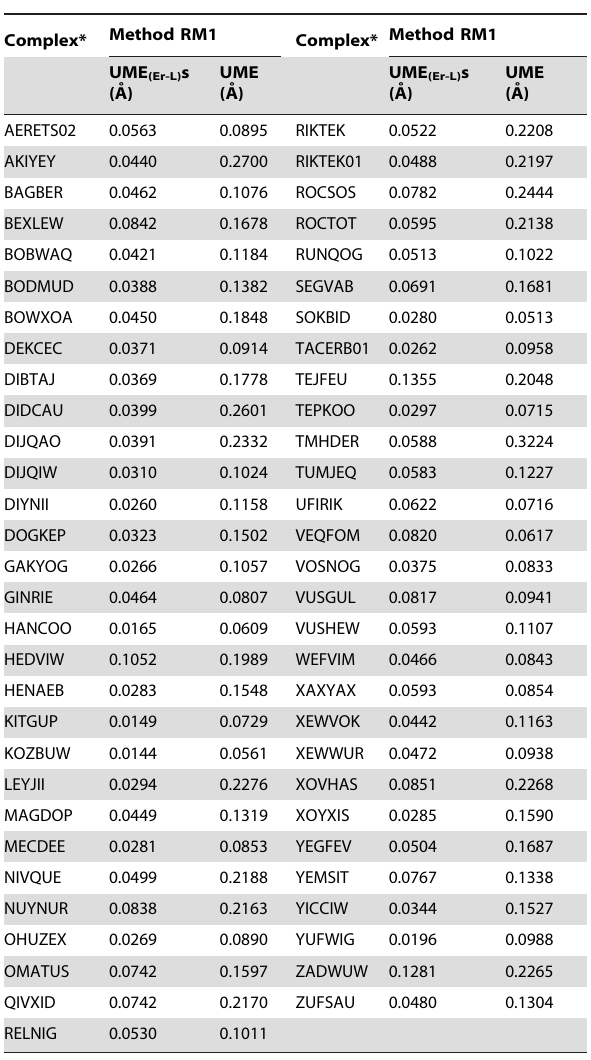
Table 4. Unsigned mean errors, UME (Er-L) s and UMEs, for Method RM1, as compared to the respective experimental crystallographic values, obtained from the Cambridge Structural Database, [37–39] for each of the 59 erbium (III) complexes.